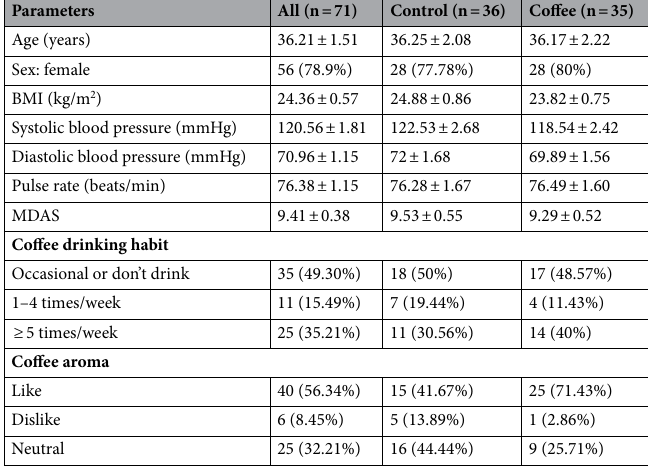
Table 1. Baseline characteristics of the subjects (mean ± SEM).